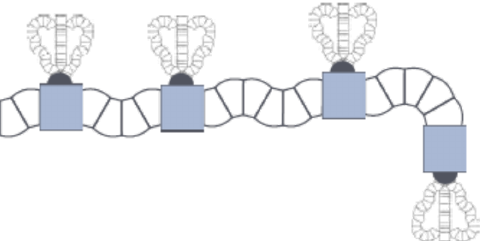
Figure 13. A four-gripper articulating tentacle resulting from applying